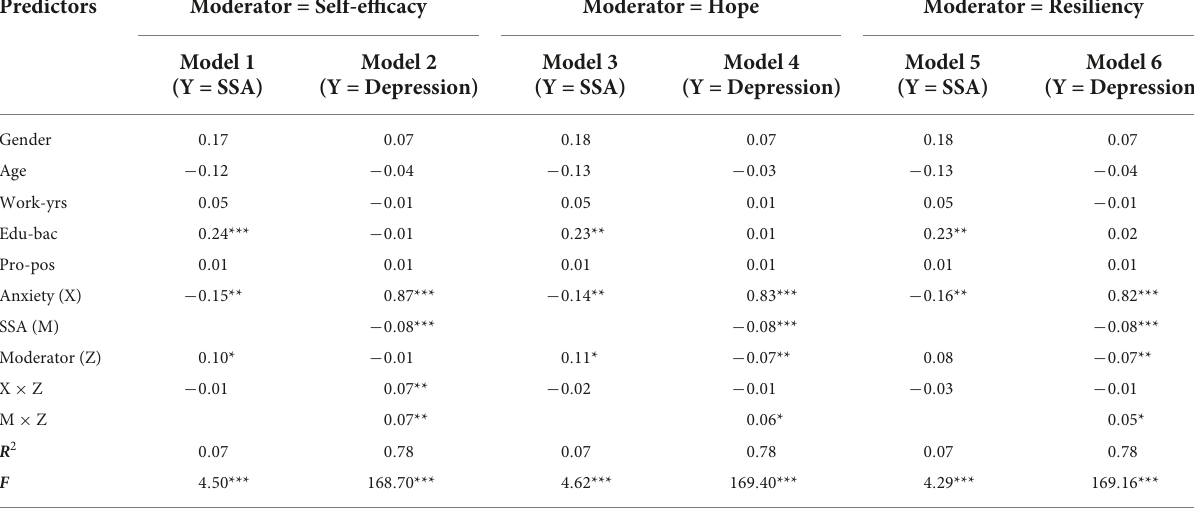
TABLE 6 Model coefficients for moderated mediation analysis of components of